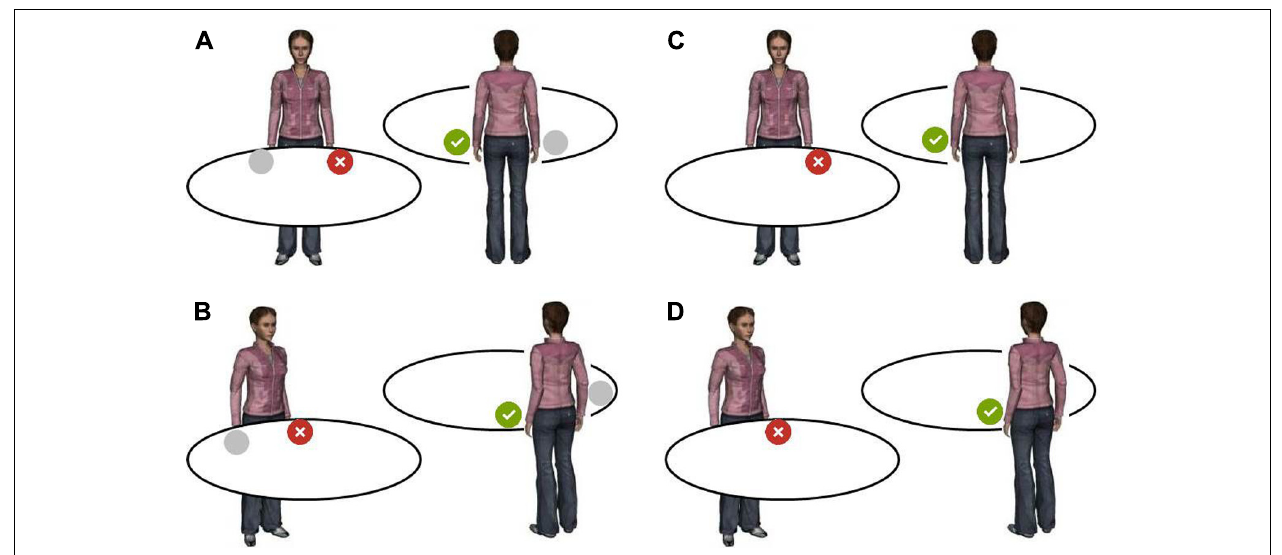
side: Stimuli that request relative judgments (A, B) : Is the left or right stimulus from the avatar’s perspective the critical one? Right side: Stimuli that request absolute judgments (C, D) : is the critical object on the left or right side from the avatar’s perspective? Only figures with the critical object on the avatar’s left side are shown; compatibilities are the same for right-side